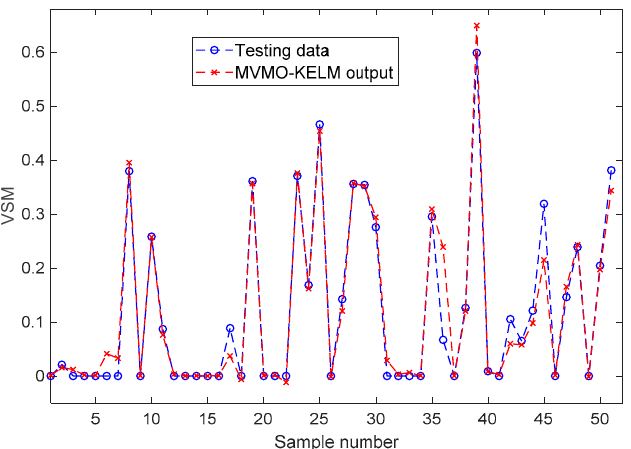
Figure 8. Comparison between actual and predicted values of VSM with MVMO-Kernel Extreme Learning Machine (KELM).